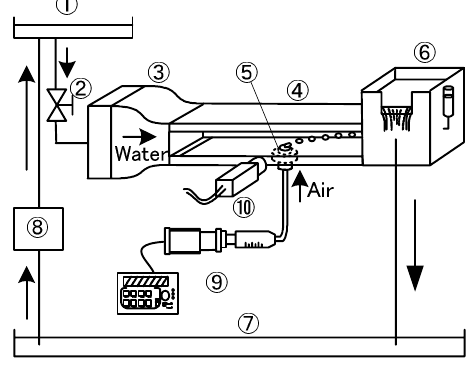
Fig. 1 Schematic of the experimental